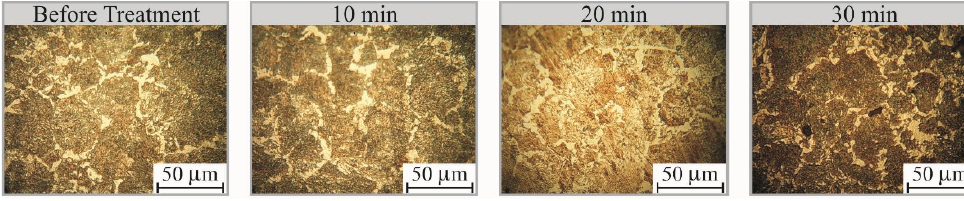
Figure 3. Dynamics of changes in the microstructure of 45 steel after ultrasonic treatment. It can be seen that the 45 steel before treatment had a similar structure to 40kH steel, with a slight increase in the proportion of pearlite. However, the growth in erosional damage showed some differences. The first erosional pits arose by 20 min of treatment, when the structure was not refined. Further treatment led to an increase in the number of